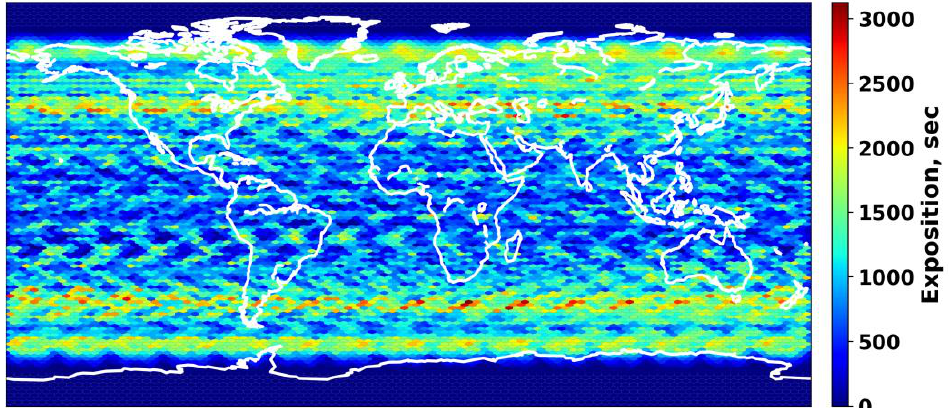
Figure 11. The map of Earth’s surface coverage by MLHS observations for the period from 10 October 2019 to 8 October 2020. The color bar corresponds to Sun observations’ exposure time value within the tangent height range of 5 – 50 km. (For interpretation of the references to color in this figure, the reader is referred to the web version of this article).